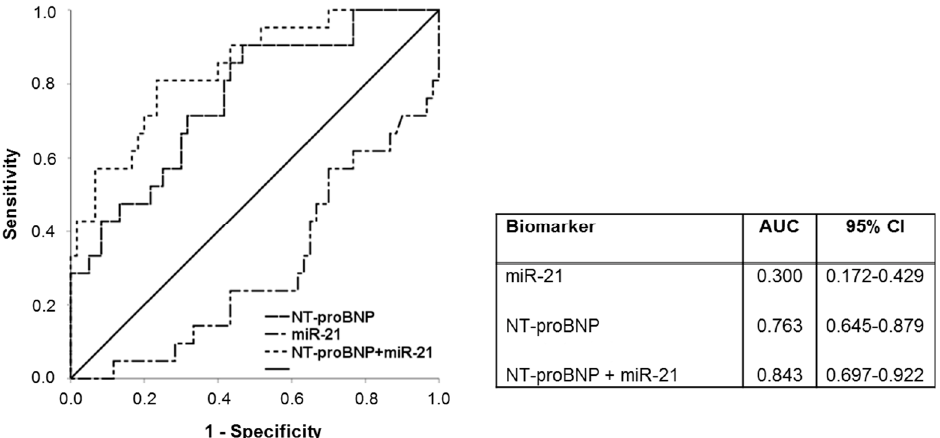
Figure 5. ROC-curve analysis of NT-proBNP, miR − 21 and combined NT-proBNP and miR − 21. miR- Micro ribonucleic acid, NT-proBNP- N-terminal pro-brain natriuretic peptide.